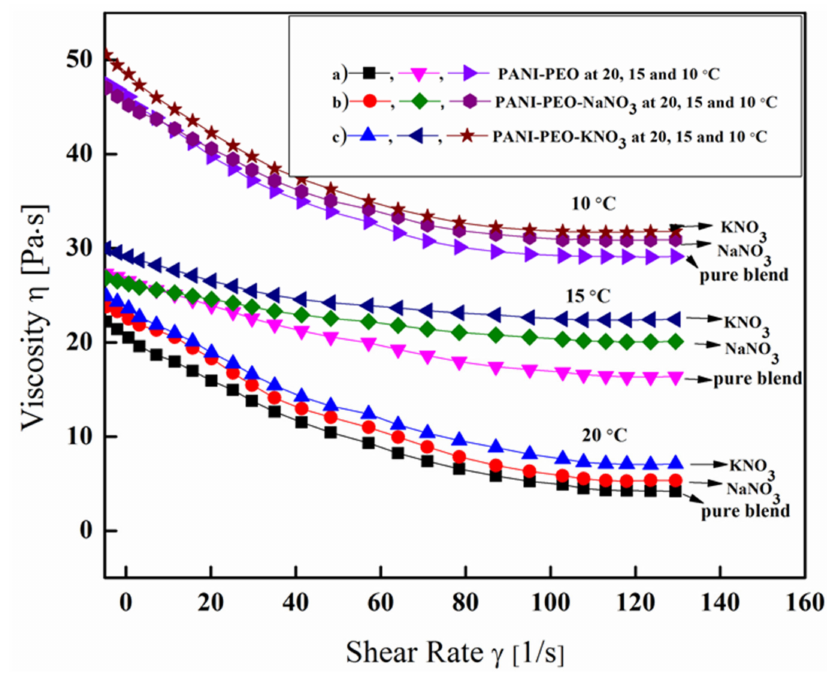
Figure 7. Dependence of viscosity of ( a ) PANI-PEO pure blend ( b ) PANI-PEO-NaNO 3 ( c ) PANI-PEO-KNO 3 at 20 ◦ C, 15 ◦ C and 10 ◦